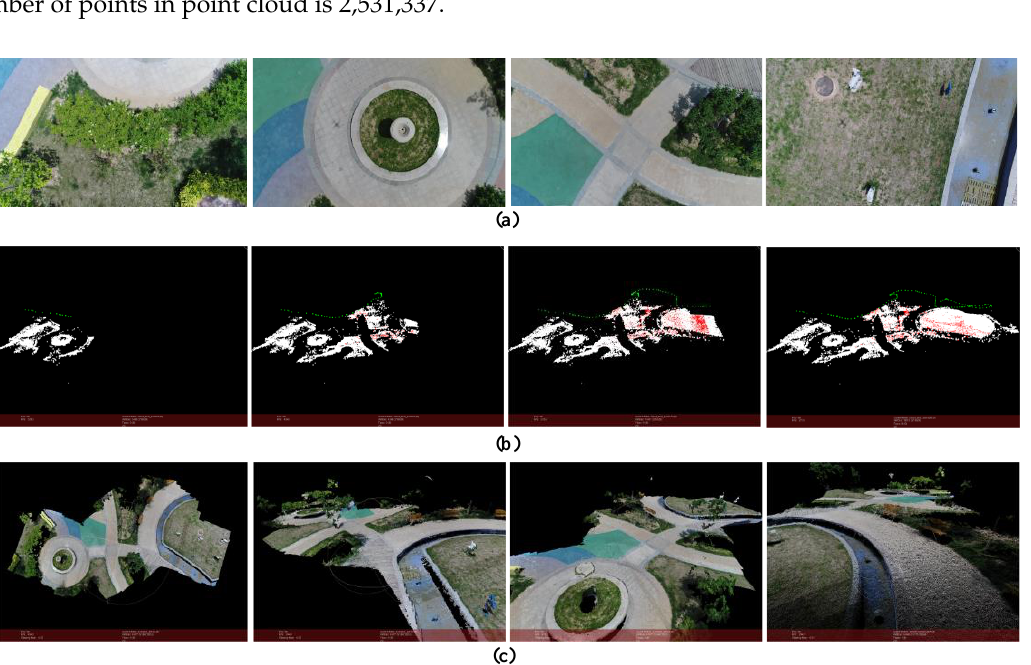
Figure 13. Reconstruction result of a garden. ( a ) Part of the images used for reconstruction; ( b ) Structure calculation of image queue SfM (green points represent the positions of the camera); ( c ) Dense point cloud of the scene.